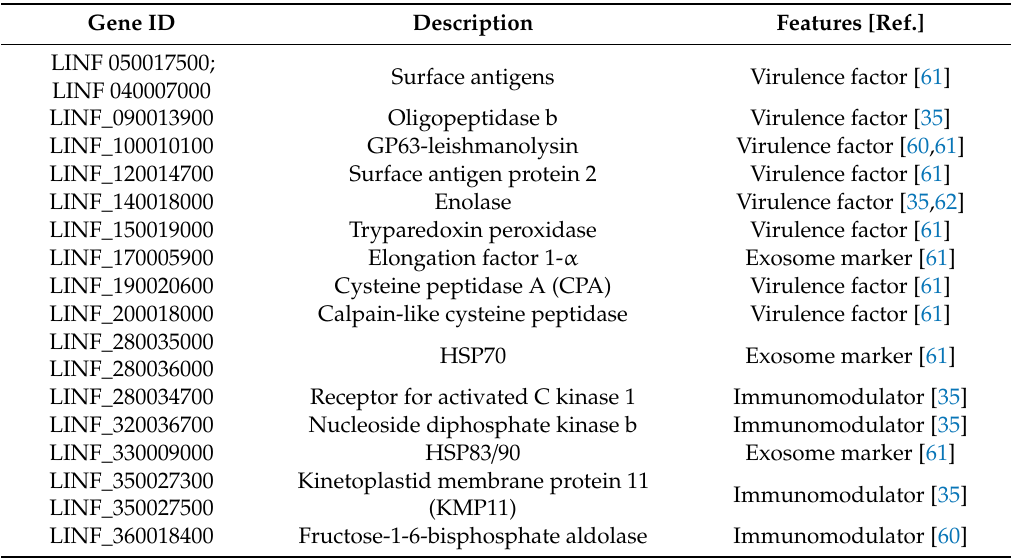
Table 5. Common components of Leishmania exosomes identified in this L. infantum proteome study. Gene